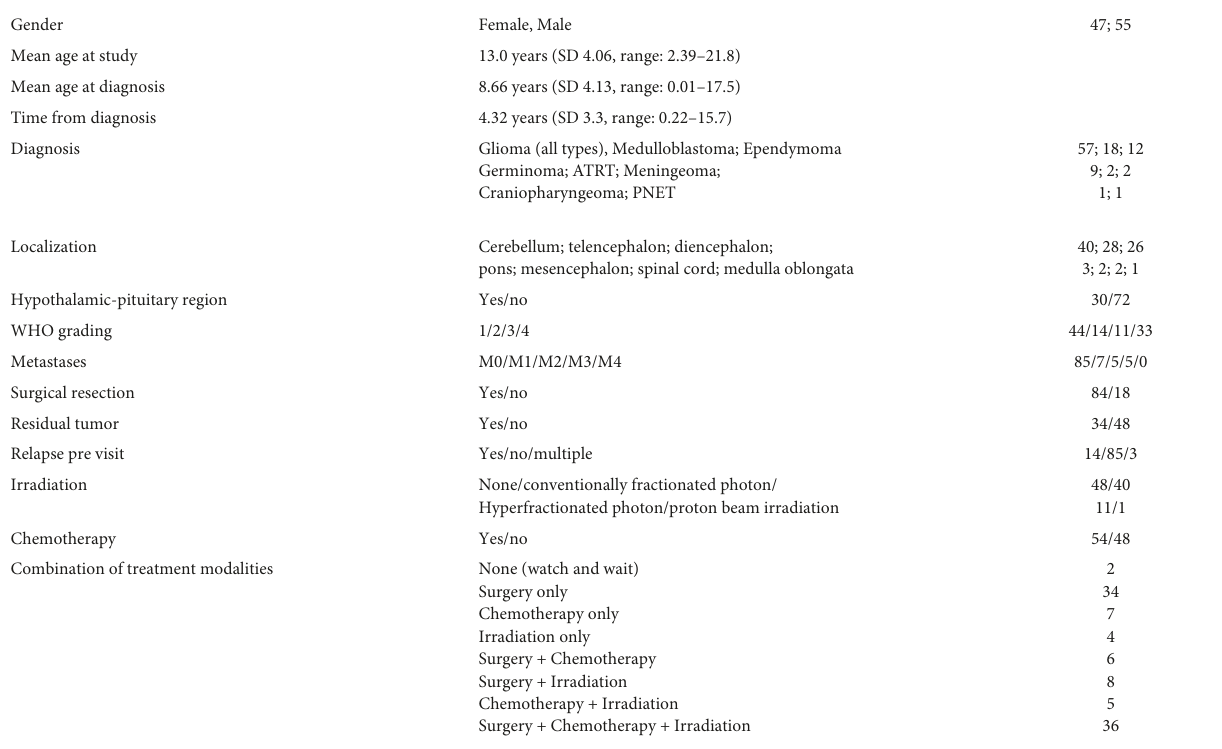
TABLE 1 Stratification and treatment of the